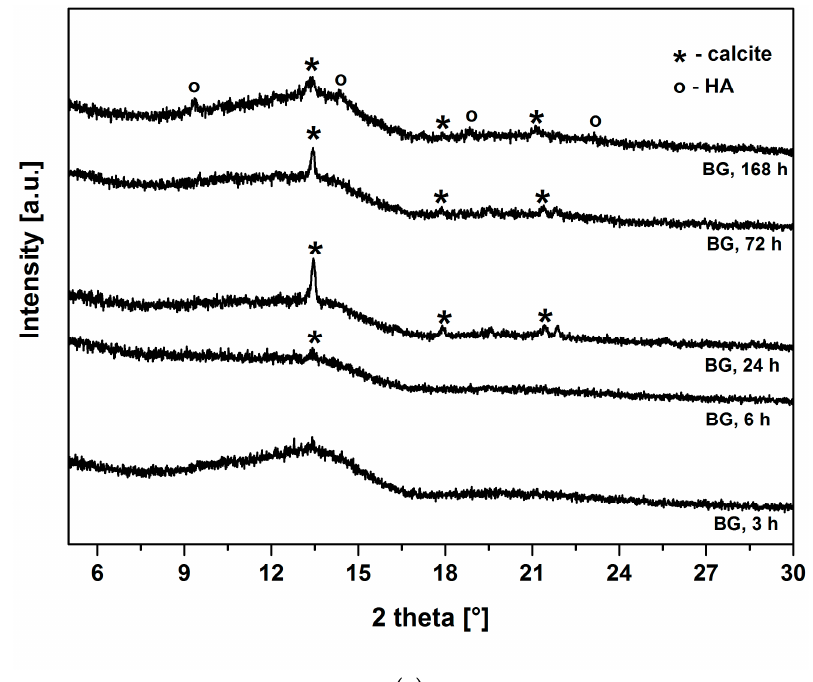
Figure 2. Ionic concentrations in SBF as function of immersion time in SBF: ( a ) BG; ( b ) BG-gly paste (right plots represent magnifications of the grayish areas from the left plots, respectively); ( c – f ) comparison of the evolution of selected ionic concentrations for BG and BG-gly (insets represent magnifications of the soaking time range up to 24